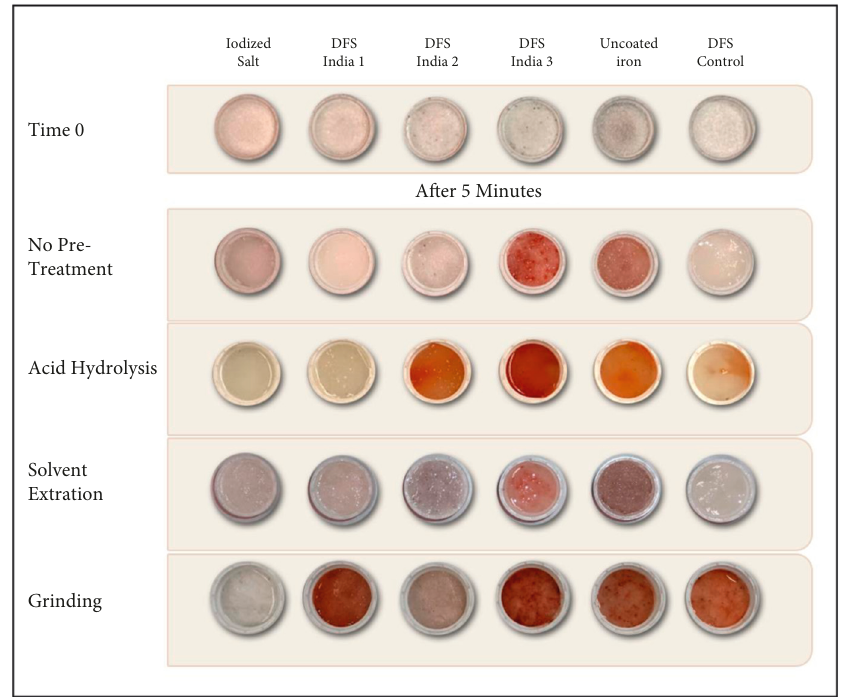
Figure 7: Qualitative DFS coating integrity test using O-phenanthroline and three different pretreatments and exposed iron from premix. Intense red-orange colour formation indicates the interaction of ferrous iron with phenanthroline and poor surface